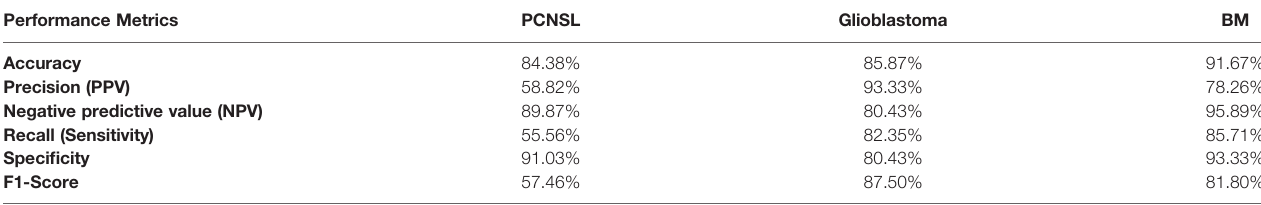
TABLE 3 | Neuroradiologists (Gold standard) performance metrics in differentiating PCNSL, Glioblastoma and BM in the cohort examined. Performance Metrics